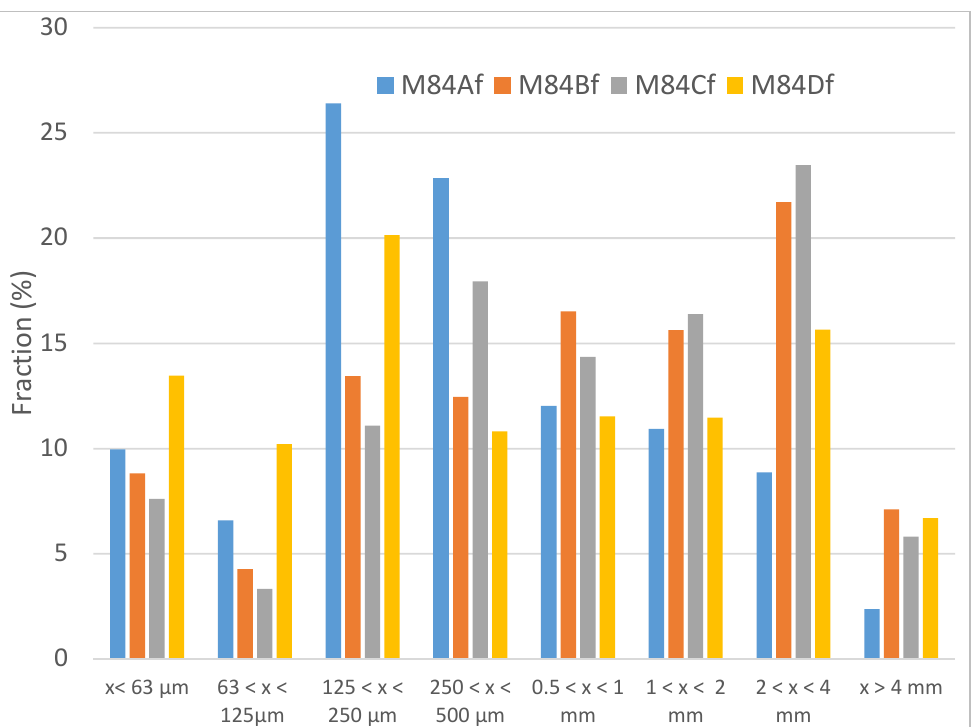
Figure 3. Percentage of fractions obtained for the raw materials samples (M84Af to Df). Materials 2020 , 13 , x FOR PEER REVIEW